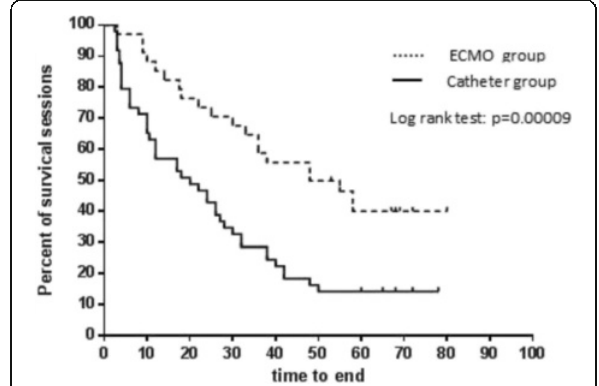
Fig. 131 (abstract A332). Kaplan-Meier of CVVH circuit survival